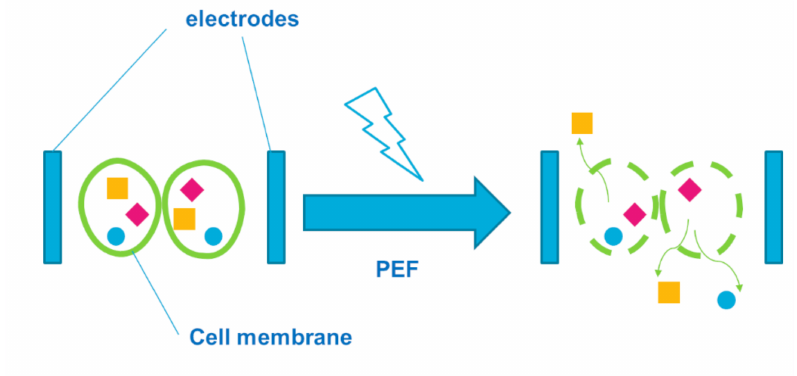
Figure 4. A scheme of PEF impact on plant material. PEF was applied to improve the extraction of juice from blueberries. Anthocyanins from blueberry pomace were investigated by Pataro et al. [120]. Blueberries, cut in half, were pretreated by PEF with different input energy values—1 kJ/kg, 5 kJ/kg or 10 kJ/kg—before juice pressing. In all the samples of pomace obtained after pressing blueberries pretreated with PEF, TAC and AA were increased compared to the control (a sample of pomace remaining after pressing the juice from blueberries untreated with PEF). A correlation between increased energy input and increased values of both TAC and AA was